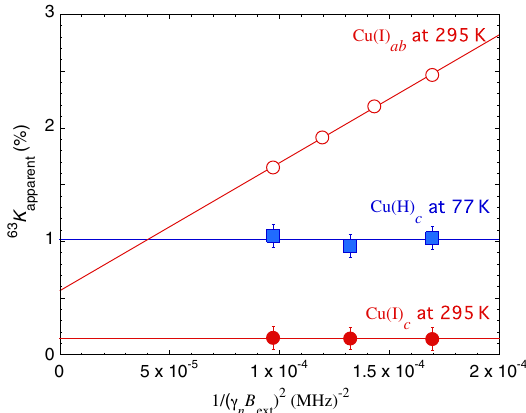
FIG. 12. The plot of 63 K versus the spin contribution χ 2 Þ Q based on Cu 2 IrO 3 , choosing temperature as the implicit parameter. The in several magnetic fields. The solid lines represent the best liner fit through the origin. χ apparent 2 ¼ 0 to the limit of 1 = ð γ n B enhanced by defect spin contributions in the yellow shaded apparent ext Þ region, where the linearity breaks